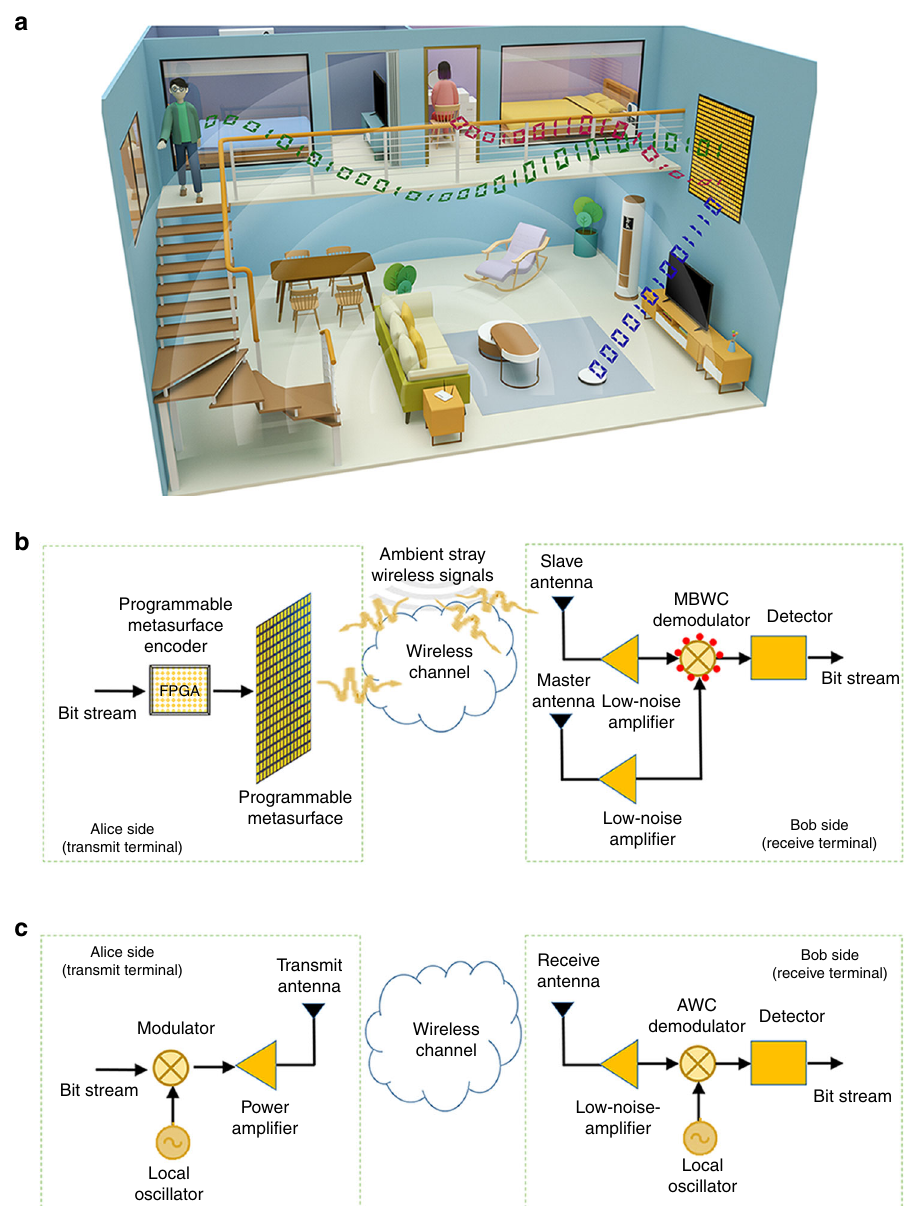
Fig. 1 Principle of the proposed MBWC. a An illustrative scenario for the proposed MBWC in a typical indoor environment. Here, a programmable metasurface partially decorating the wall transmits simultaneously three direction-dependent streams of digital information to three users (two people upstairs and a robot in the living room) by modulating the ambient stray electromagnetic waves. b Block diagram for the proposed MBWC. The programmable metasurface-based encoder maps the digital bit “ 0 ” ( “ 1 ” ) to the metasurface con fi guration C 0 ( C 1 ). c Block diagram for